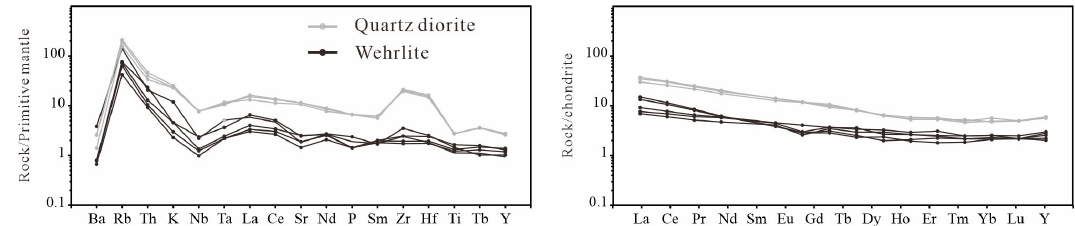
Figure 5. Primitive mantle-normalized trace element spider diagram and chondrite-normalized REE diagram (primitive mantle data after [40,41]).